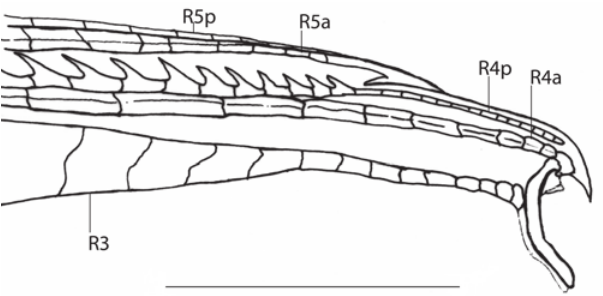
Fig. 31. Gonopodium tip of Phalloceros ocellatus , MCP 39121. R3, R4a, R4p, R5a, R5p indicate gonopodial rays. Scale bar 1